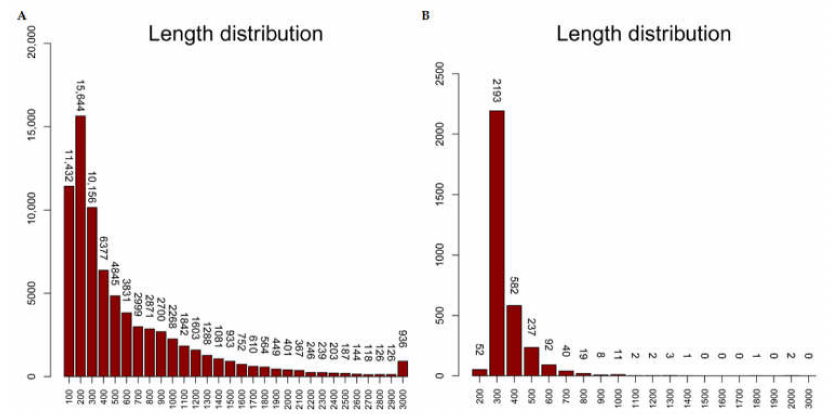
Figure 3. Open reading frame (ORF) length distribution of the annotated contigs ( A ) and the predicted ORF length distribution of the unannotated contigs ( B ) in M. amblycephala .